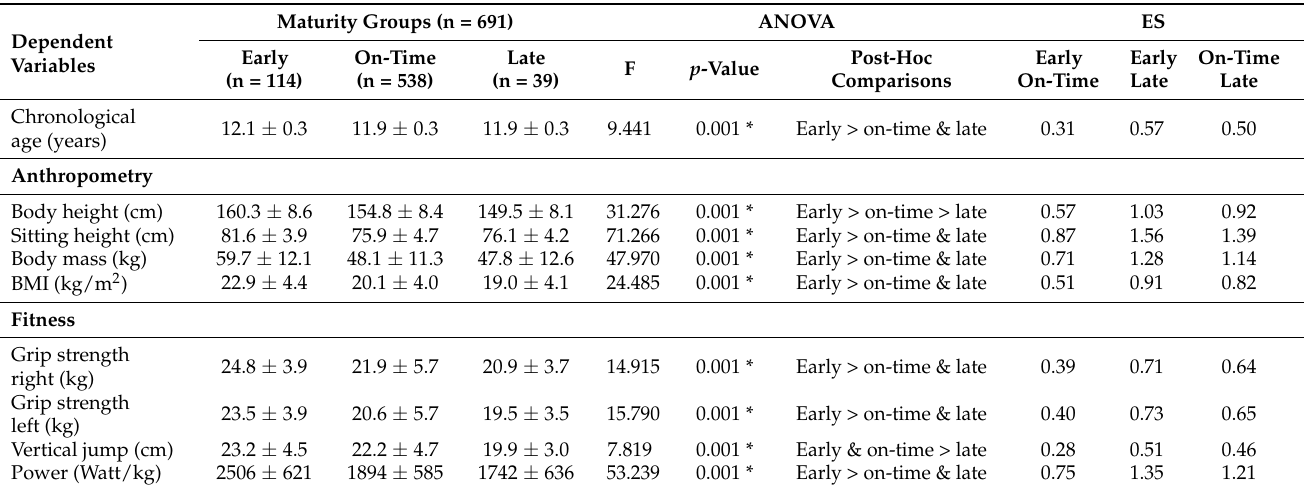
Table 3. Descriptive statistics of boys and girls by maturity status and the results of ANOVA test, post-hoc comparisons, and effect size